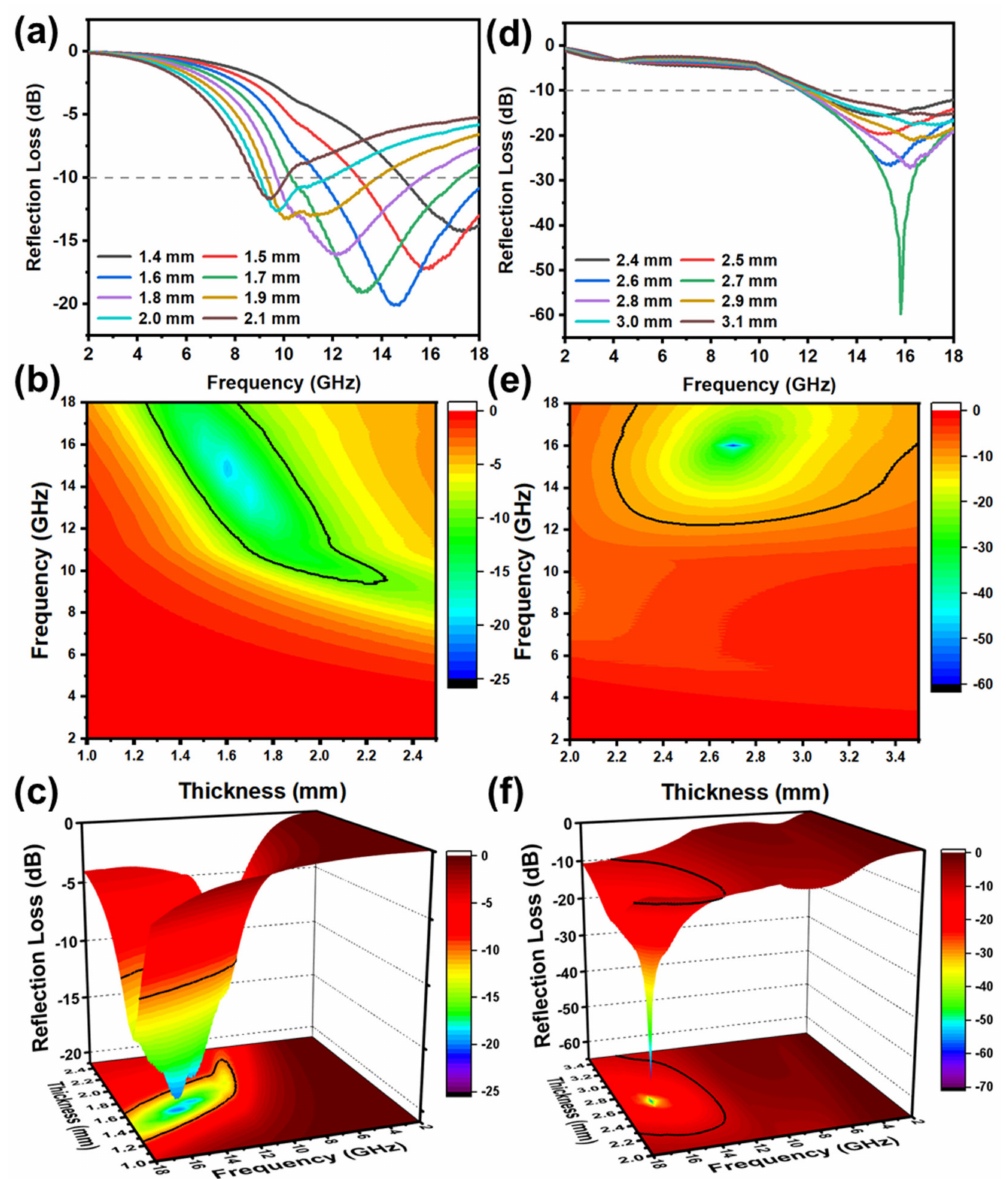
Figure 6. ( a ) The theoretical images, ( b ) 2D contours, and ( c ) 3D images of flower-like ZnO/PPy composites; ( d ) the theoretical images, ( e ) 2D contours, and ( f ) 3D images of rod-like ZnO/PPy